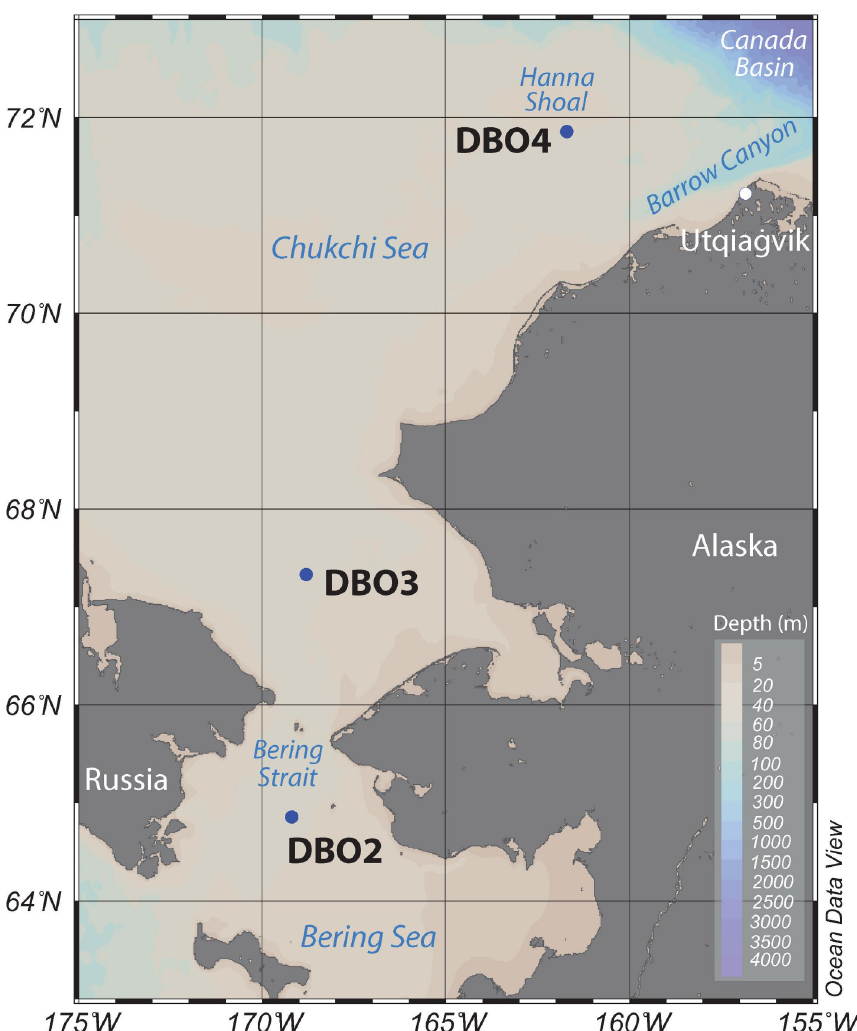
Fig 1. Positions of the three mooring sites at the DBO hotspots in the Pacific Arctic region. Reprinted from Ocean Data View under a CC BY license, with permission from Reiner Schlitzer, original copyright